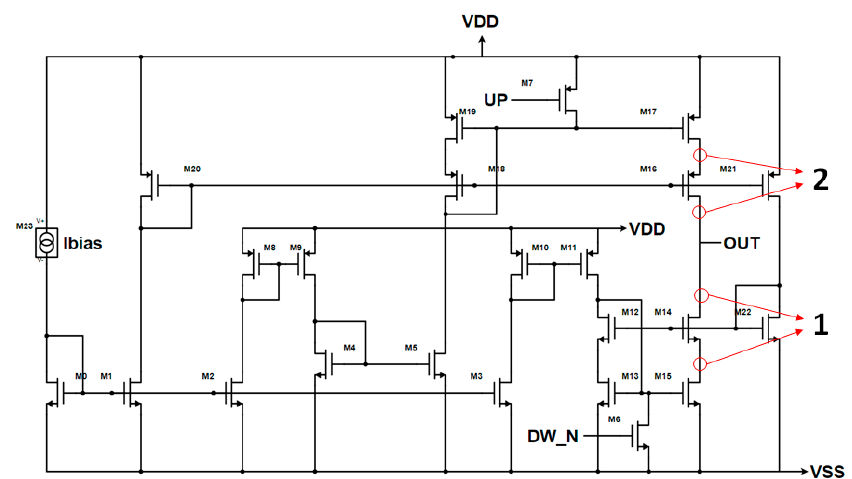
Figure 19. Highlight of the output nodes of the CP.